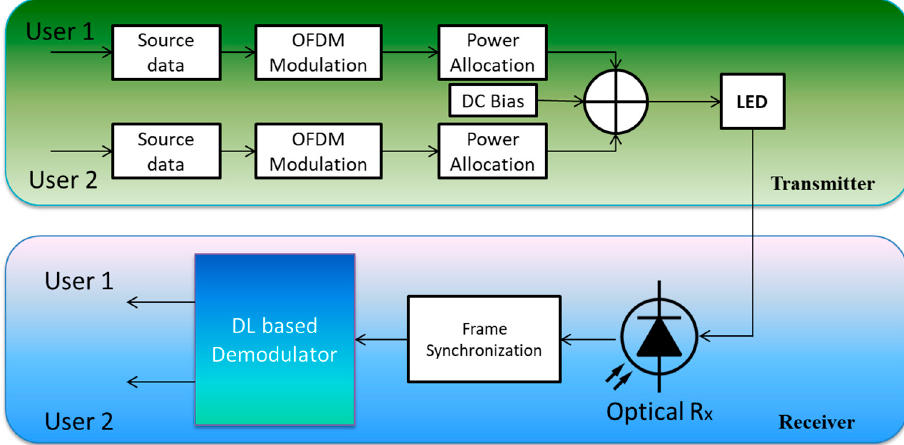
Figure 2. An illustration of DL-based NOMA-VLC system.